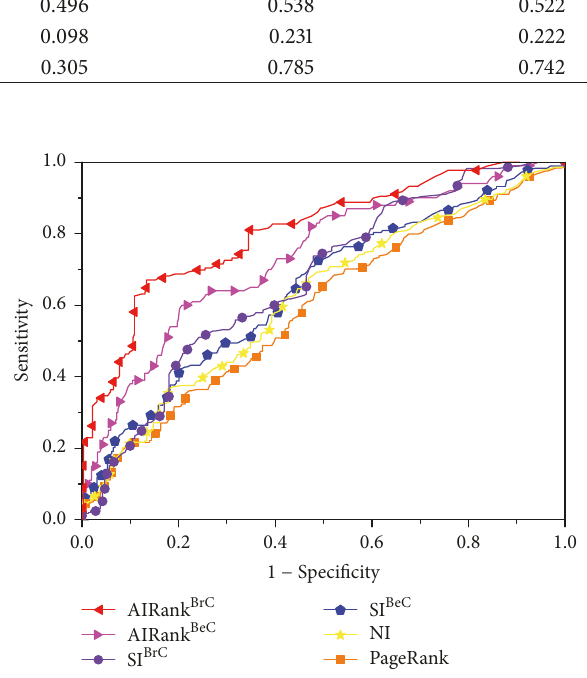
Figure 9: ROC curves of SI BrC , SI BeC , NI, AIRank BrC , and AIRank BeC